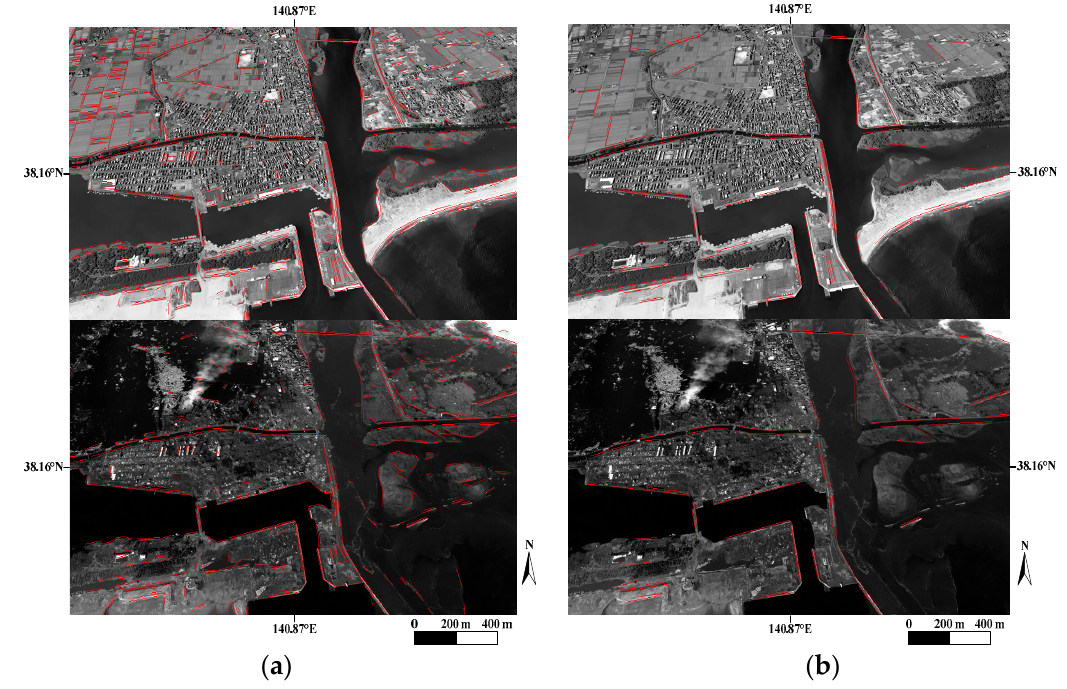
Figure 5. Results of line segment extraction. ( a ) Results of the EDLines algorithm on two corresponding images; ( b ) results of the line segment validation step implemented in ( a ).